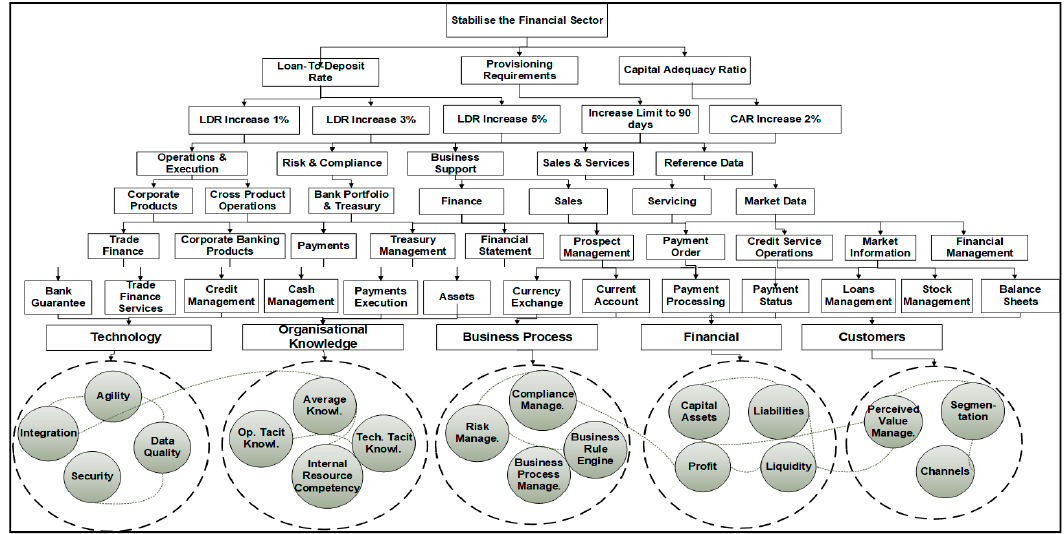
Figure 3. Application of ‘Stabilise the financial sector in SAMA’.